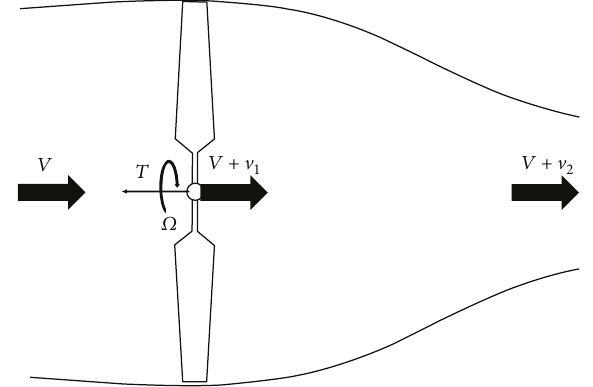
Figure 1: Propeller slipstream with axial velocity representation.